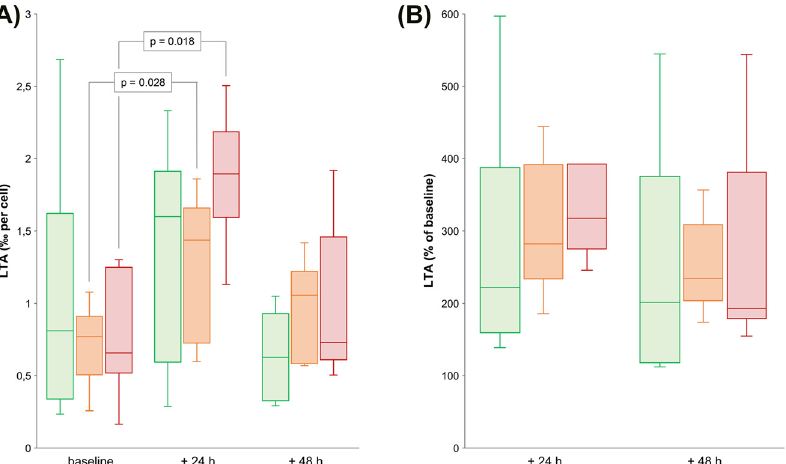
Figure 1: Dynamics of leukocyte telomerase activity before and after low (green, n=7), moderate (orange, n=7) and high (red, n=7) intensity exercise